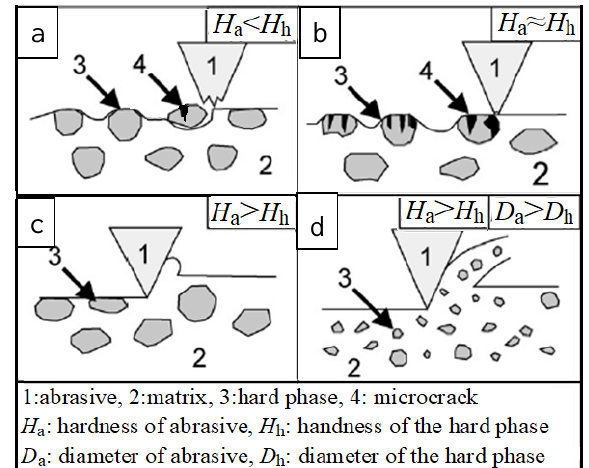
Figure 8. Typical worn surface morphologies of the three WC-20Cr 3 C 2 -7Ni coatings: ( a – c ) three-body abrasive wear (180-mesh SiO 2 abrasive); ( d – f ) three-body abrasive wear (180-mesh SiC abrasive); ( g – i ) two-body abrasive wear (180-mesh SiC sandpaper); ( a , d , g ) FC coating, ( b , e , h ) MC coating, ( c , f , i ) CC coating.